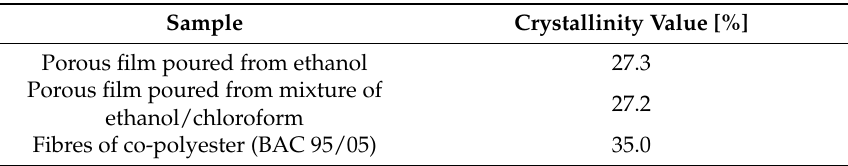
Table 5. The scale of the crystallinity of films from butyric-acetic chitin co-polyesters 90/10 manufactured using the method of pouring on the layer of inorganic salt crystals and poured in the form of suspension of salt in the polymer